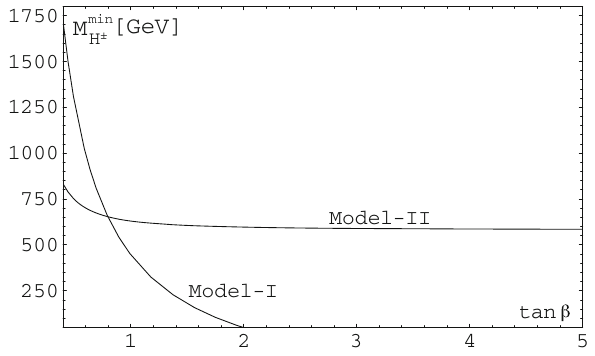
Fig. 18 2HDM 95%C.L. B → X s γ exclusion ( lower part ) in the plane of tan β and M H ± . (Reprinted with kind permission from the authors, Fig. 4 of